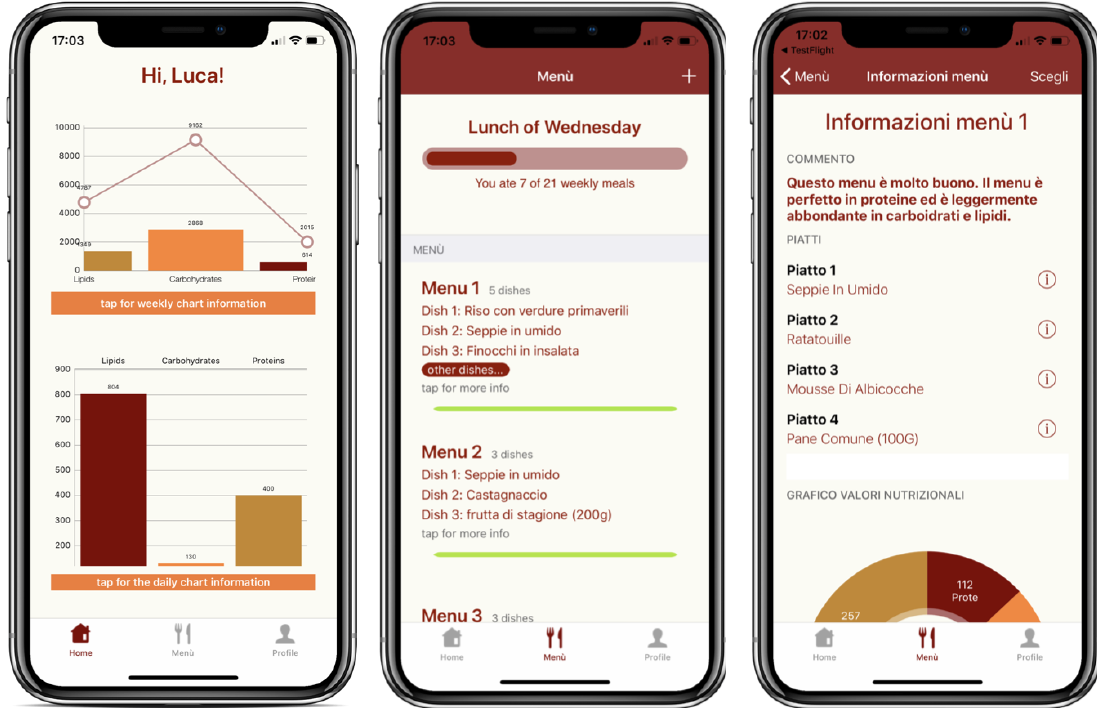
Figure 8. Three screenshots of the CheckYourMeal! app. The user interface is structured into three sections: the Home Section (left), where the users are provided with general information on the weekly diet; the Menu Section (centre), where the users can see the suggestions for the next meal and where they can input the chosen meals; and the Recommendation Section (right), where the users visualize both a textual message and a pie chart containing information about the macronutrient values of a specific